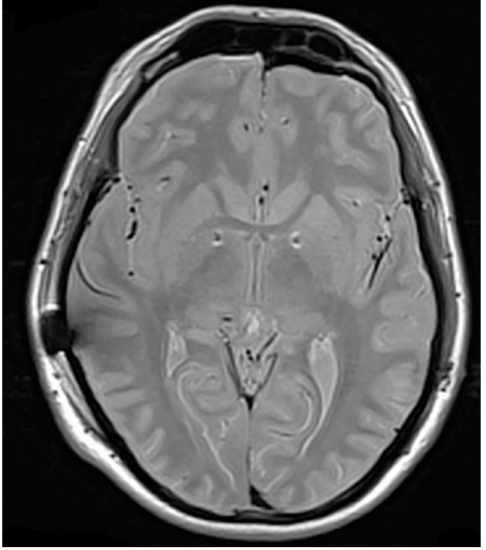
Figure 2. Axial T2-weighted MRI sequences showing electrodes in the anteromedial part of globus pallidus internus (1.5